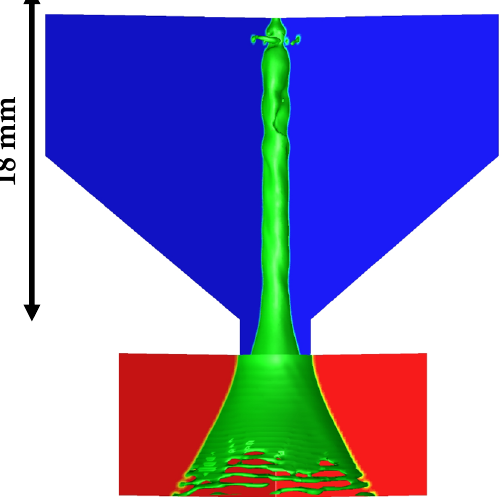
Figure 7. Typical results obtained from 3D periodic mesh with 27 cells in r o , transient, Laminar simulation. Re = 2000, instantaneous image. Blue and red represent liquid and air, respectively, and green is an interface.